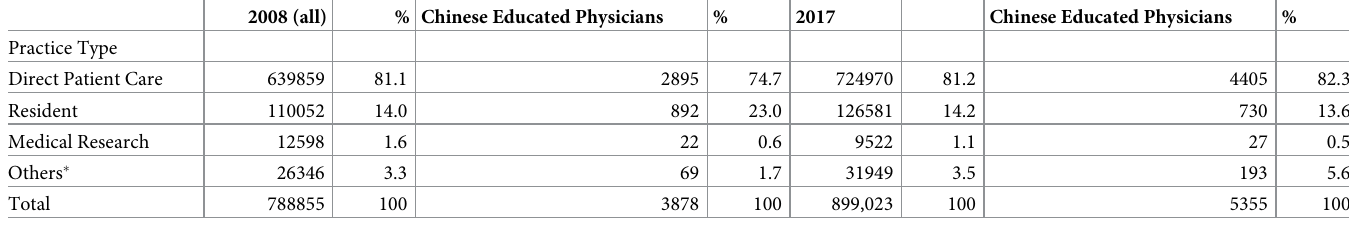
Table 1. Practice type of active physicians in 2008 and 2017.